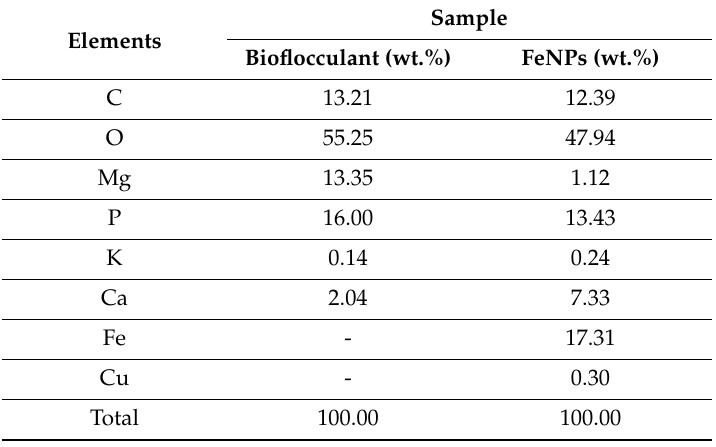
Figure 3. SEM surface morphology of the iron nanoparticles.